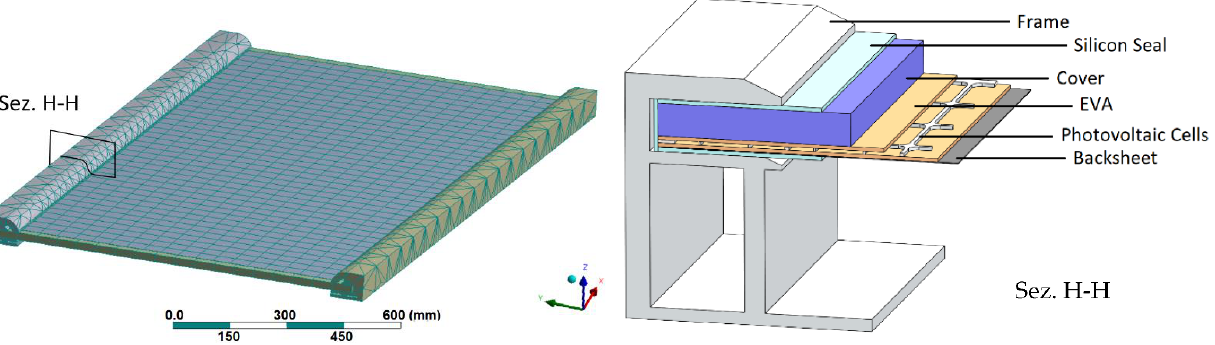
Figure 12. Parametric FE model of silicon-based PV panels with support.